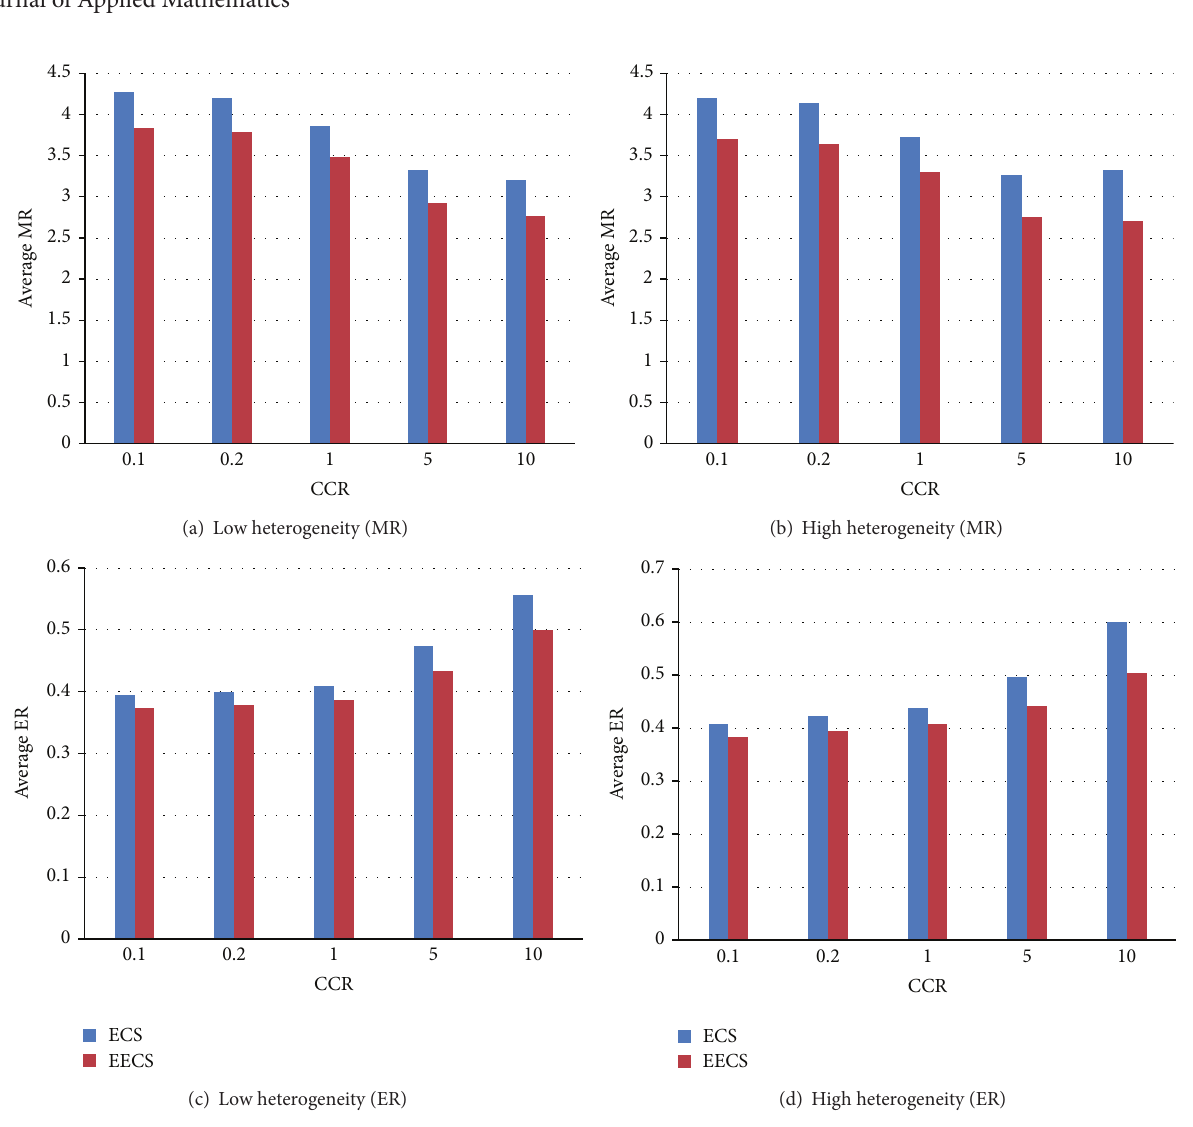
Figure 7: Random DAGs (different heterogeneities of